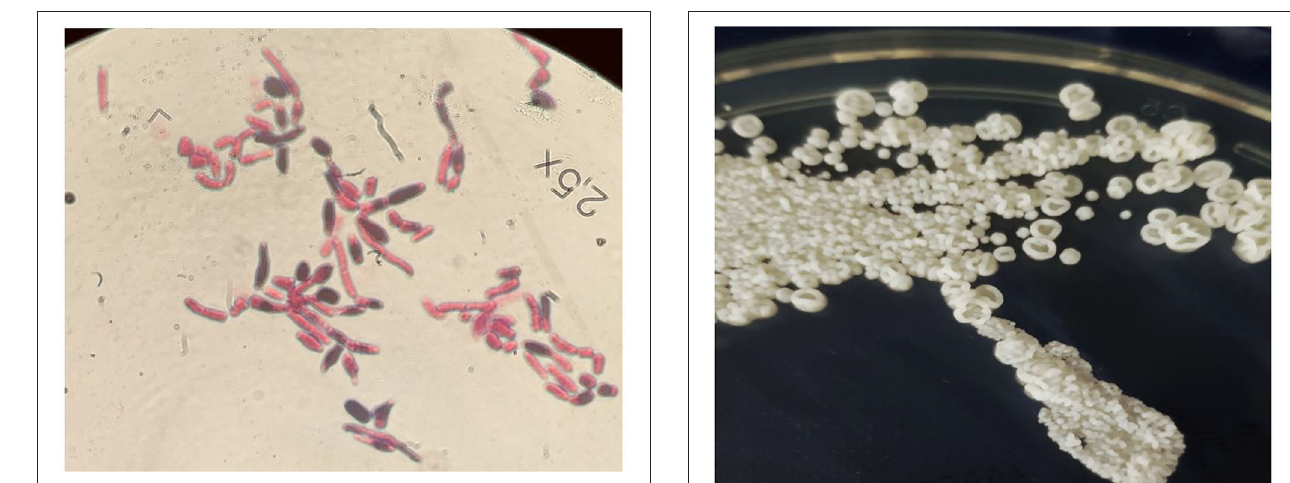
FIGURE 1 | Microscopic appearance of T . japonicum isolates with Gram stain using RAL-stainer, magnified 100 times.